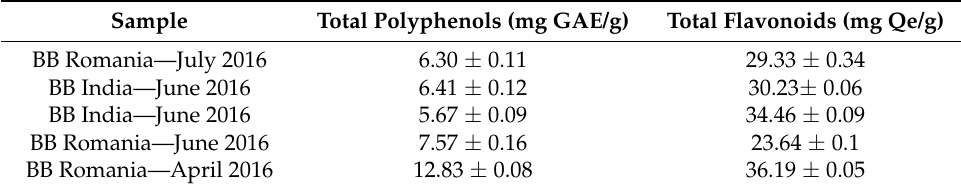
Table 3. Content in phenol and polyphenolic compounds.